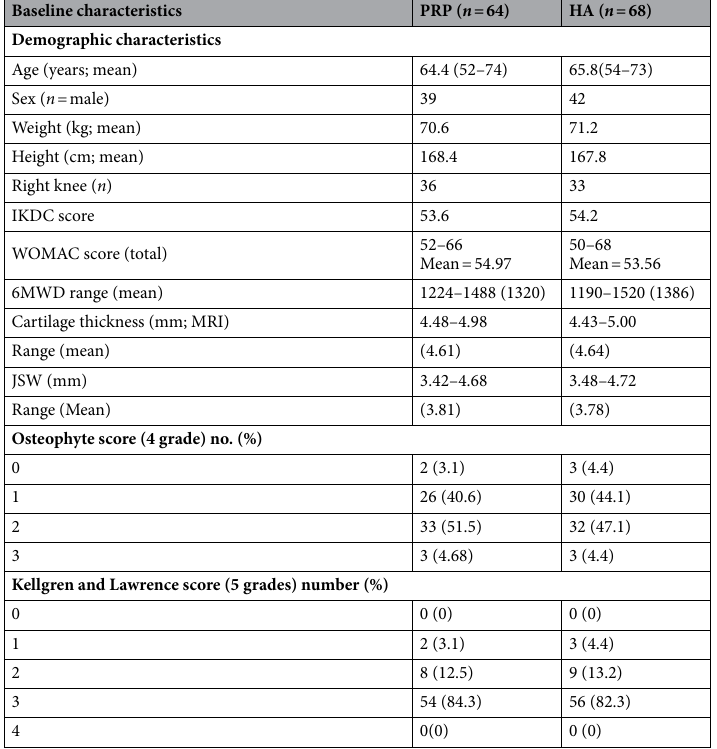
Table 1. Baseline clinical characteristics of patients with OA knee treated with PRP or HA. 6MWD 6-min walking distance, PRP Platelet-rich plasma, HA Hyaluronic acid, IKDC International Knee